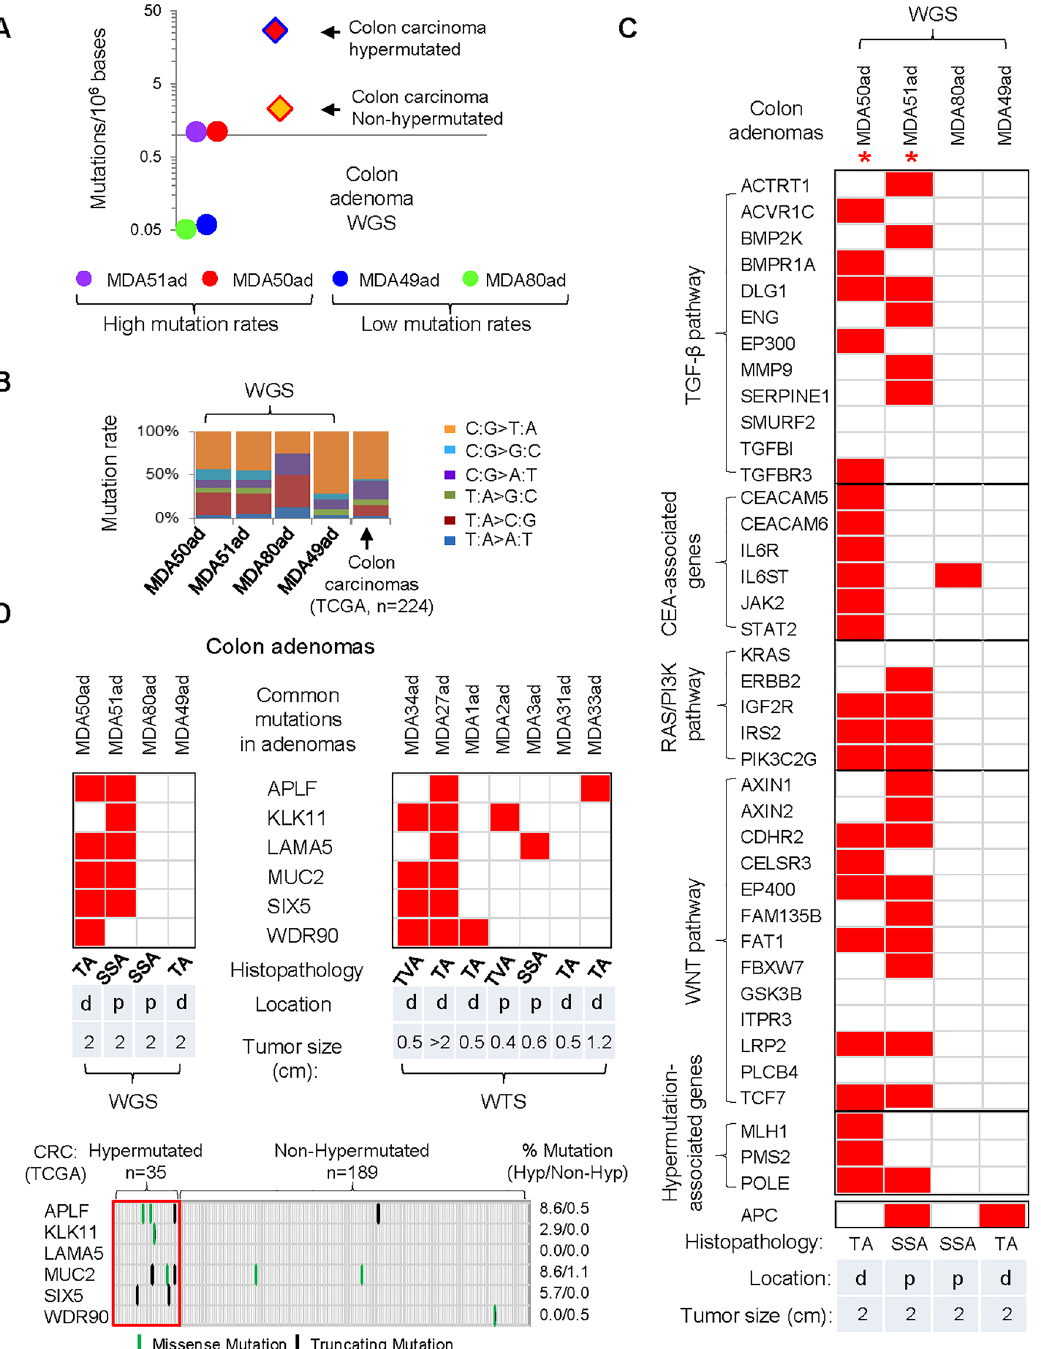
Fig 1. Frequent mutations are observed in colon adenomas. (A) Mutation frequency detected by whole-genome (WGS) sequencing of colon adenoma tissues. The dot represents the number of mutations per Mb in one adenoma sample. The red and orange diamonds represent the median mutation per Mb as observed in the colorectal cancer samples from the TCGA database. (B) Transitional single nucleotide substitutions of C:G > T:A predominate in the adenoma mutational spectrum. (C) Mutation profile of 4 pairs of matched colon adenoma samples and normal mucosa. Each colored dot indicates a mutation in the sample. * : adenomas with high mutation rates. TA: Tubular adenoma; TVA: Tubulovillous adenoma; SSA: Sessile serrated adenoma. Location d: distal; p: proximal. (D) Six most commonly mutated genes observed in 11 colon adenoma tissues (upper panels). These commonly mutated genes in adenoma samples are not frequently mutated in the hypermutated (n = 35, 0 – 8.6%) and non-hypermutated (n = 189, 0 – 1.1%) TCGA CRC carcinoma cohort (total n = 224, lower panel).